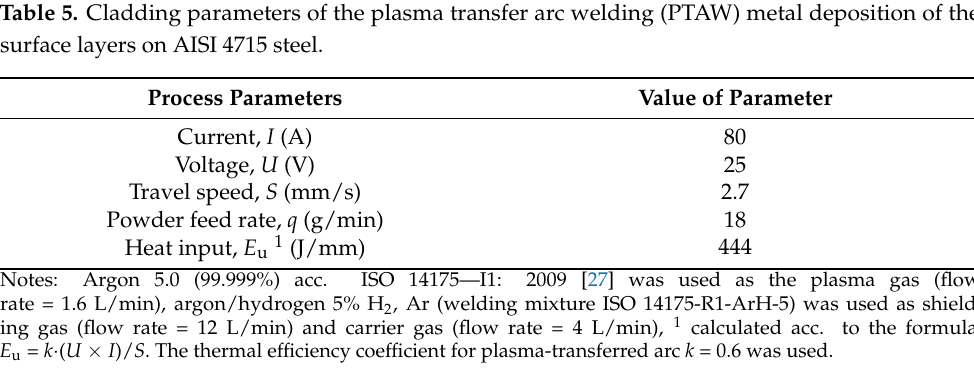
Table 4. Chemical composition of low-alloy structural steel AISI 4715 according to the manufacturer’s data (TimkenSteel Ltd., Canton, OH, USA). Chemical Composition, wt.% C Mn S P Si Cr Mo Ni Fe 0.12–0.18 0.65–0.95 ≤ 0.015 ≤ 0.015 0.15–0.35 0.40–0.70 0.45–0.60 0.65–1.00 Bal.